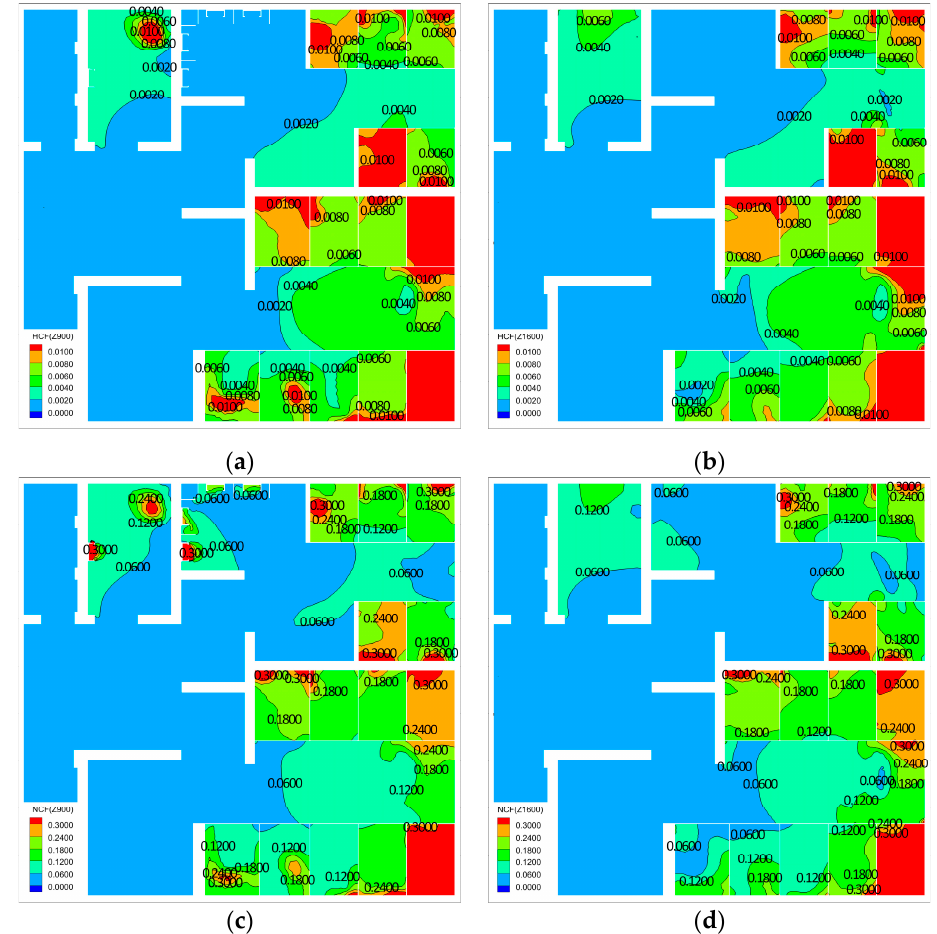
Figure 6. Concentration cloud map of pollutants in Scenario 4. ( a ) H 2 S concentration fraction (Z900); ( b ) H 2 S concentration fraction (Z1600); ( c ) NH 3 concentration fraction (Z900); ( d ) NH 3 concentration fraction (Z1600).